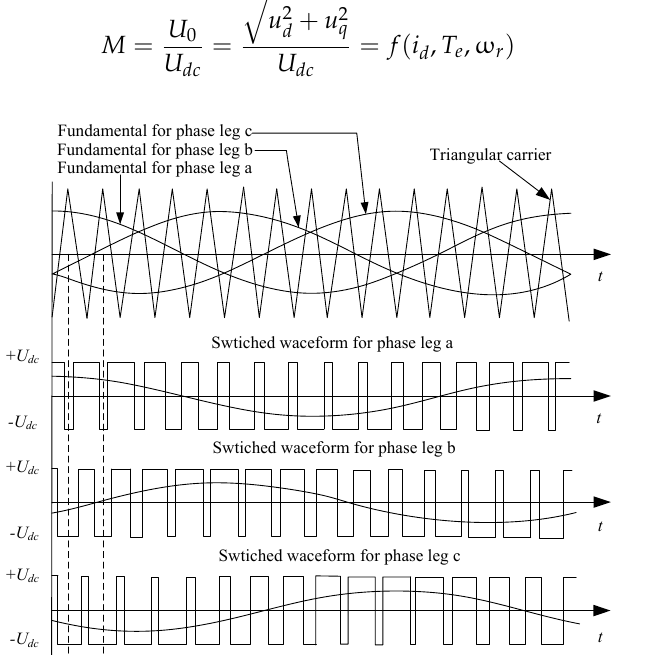
Figure 7. Typical working principle of SPWM in the three ‐ phase PMSM power system.